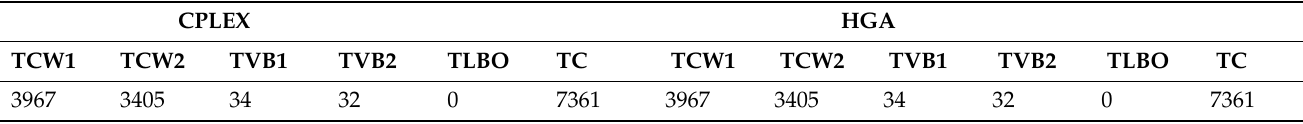
Table 4. Comparison of the results found by HGA and